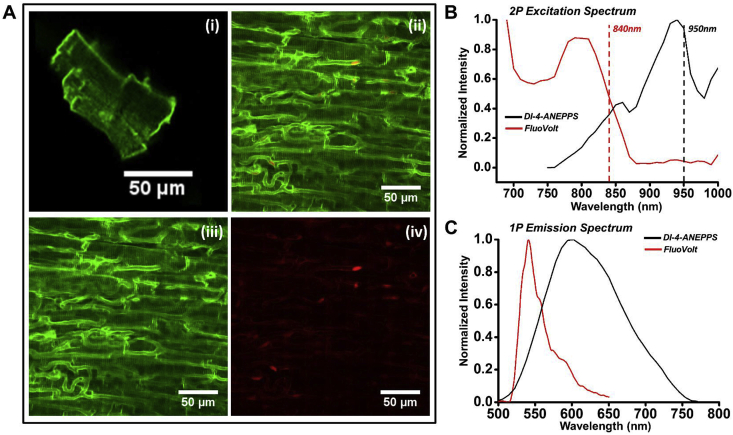
Spectral characterization of FluoVolt. (A) Two-photon excitation images of (i) an isolated rat ventricular cardiomyocyte stained with FluoVolt and (ii) LV murine subepicardial tissue stained with (iii) FluoVolt and (iv) Rhod-2AM. (B) Two photon (2P) excitation spectra of FluoVolt (RED) and di-4-ANEPPS (BLACK). Dashed lines indicate excitation wavelength used for in isolated hearts experiments. (C) One photon (1P) emission spectrum of FluoVolt and di-4-ANEPPS.